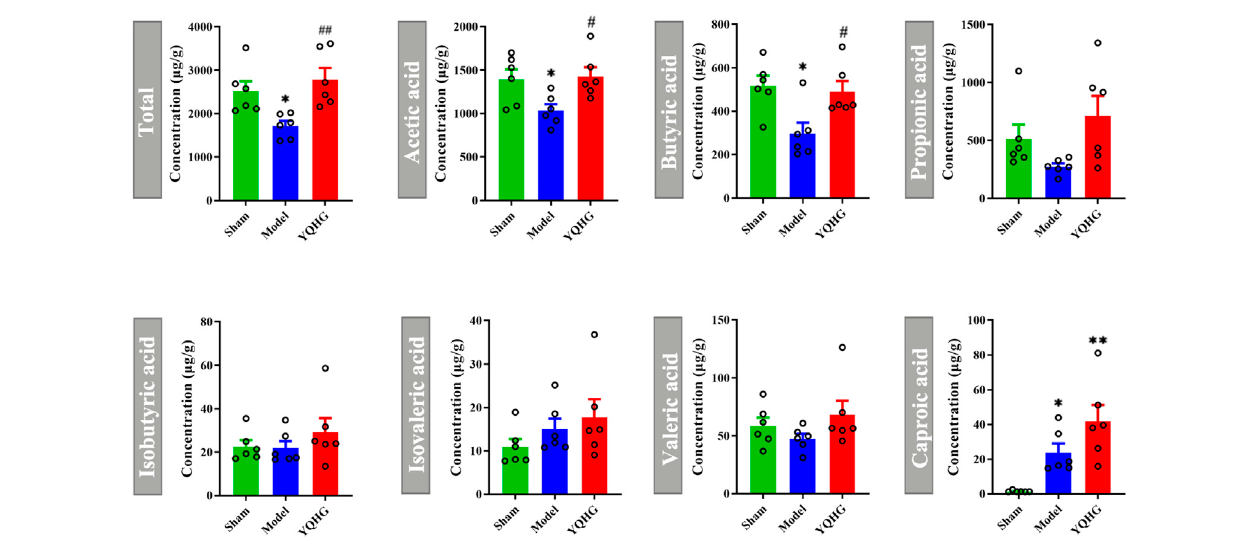
FIGURE 4 | YQHG treatment regulates the concentrations of fecal SCFAs in 5/6 nephrectomized rats. All data are expressed as means ± SEM. For normally distributeddata(Total,Aceticacid), one-way ANOVAfollowedbyTukey ’ stestwasused.Fornon-normallydistributeddata(Butyric acid,Propionic acid,Isobutyricacid, Isovaleric acid, Valeric acid, Caproic acid), Kruskal-Wallis test followed by non-parametric Wilcoxon rank-sum test was used. * p < 0.05 vs the sham group; # p < 0.05, ## p < 0.01 vs. the model